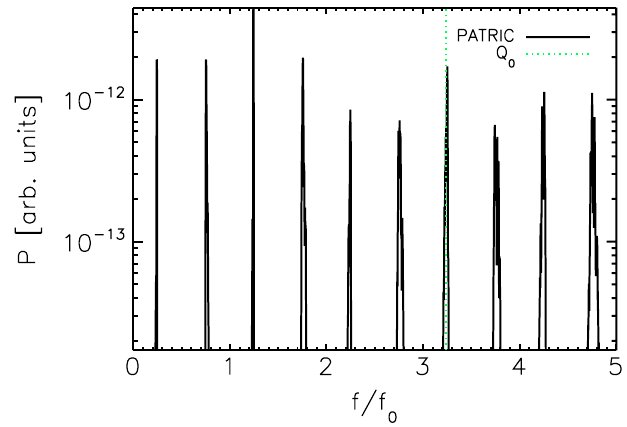
FIG. 4. Noise power spectrum obtained from the simulation code. The dotted, green curve indicates the position of the bare . tune Q 0